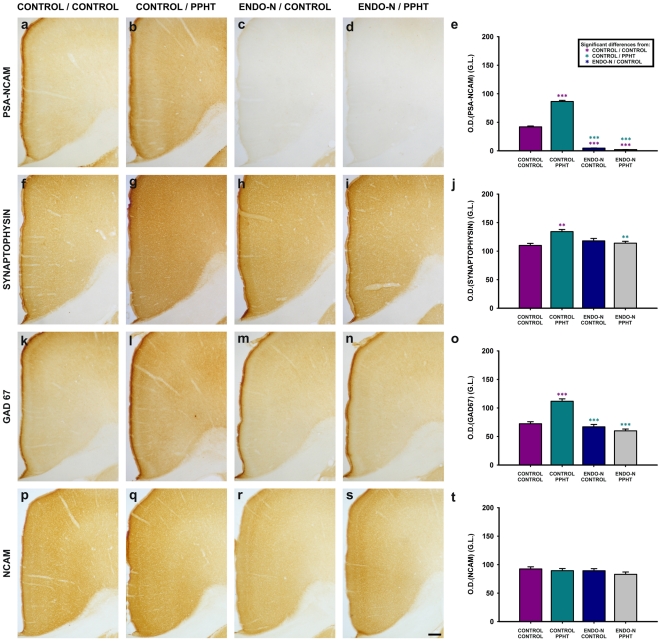
Panoramic views of the rat mPFC cortex and graphs showing the expression of PSA-NCAM (a–e), SYN (f–j), GAD67 (k–o) and NCAM (p–t) in the mPFC neuropil after Endo-N or PPHT treatments and their combination.Three sections per animal were examined under bright-field illumination, homogeneously lighted and digitalized using a CCD camera at 20× magnification. Grey levels were converted to optical densities (OD) using Image J software (NIH). Detailed description of this method of quantification can be found in material and methods S1. Note in panel c & d, the lack of PSA-NCAM expression in the cingulate cortex, but not in the striatum, demonstrating the effectiveness of Endo-N treatment. Asterisks in bars indicate statistically significant differences between groups (see graph legend) after univariate repeated measures ANOVA followed by multiple pair-wise comparisons with Bonferroni's correction; p<0.05 (*), p<0.01 (**), p<0.001 (***). Scale bar: 100 µm.